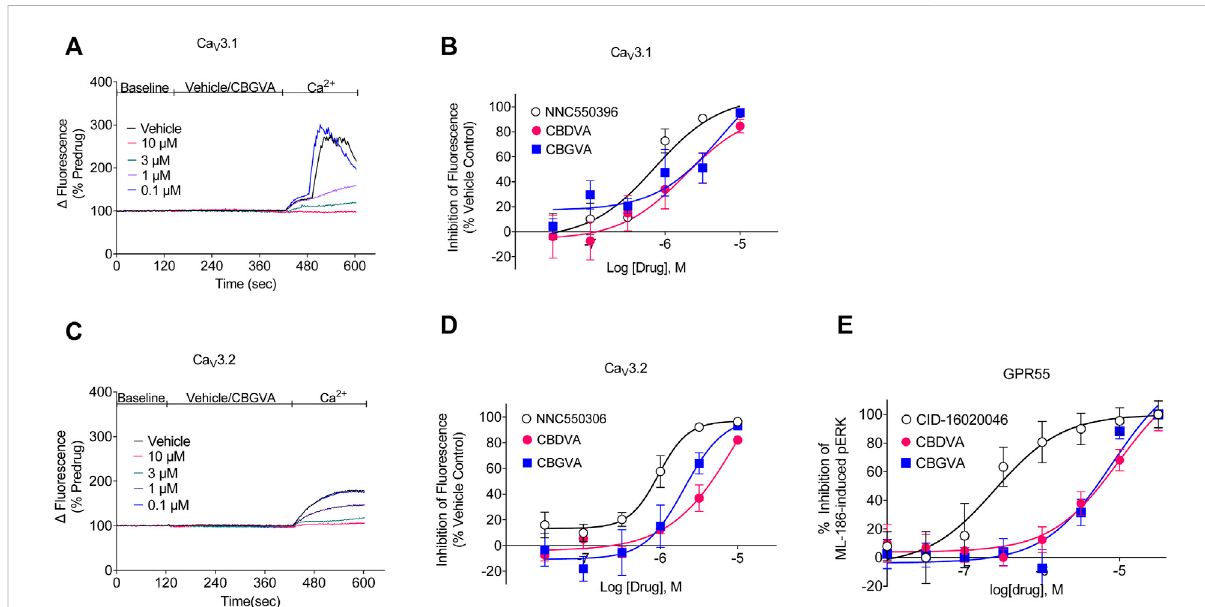
FIGURE 1 CBGVAandCBDVAinhibitCav3.1andCav3.2channelsandGPR55receptors. (A) Arepresentativetraceofthechangein fl uorescencecausedby vehicle control and CBGVA in HEK 293 Ca v 3.1 cells. After 2 min of baseline reading, vehicle or CBGVA were added for 5 min, followed by adding 10 mMCa 2+ andreadforafurther3 min. (B) Concentration-responsecurvesforNNC550396,CBGVAandCBDVAinhibitionofCa v 3.1response. (C) A representative trace of the change in fl uorescence caused by vehicle control and CBGVA in HEK 293 Ca v 3.2 cells. (D) Concentration-response